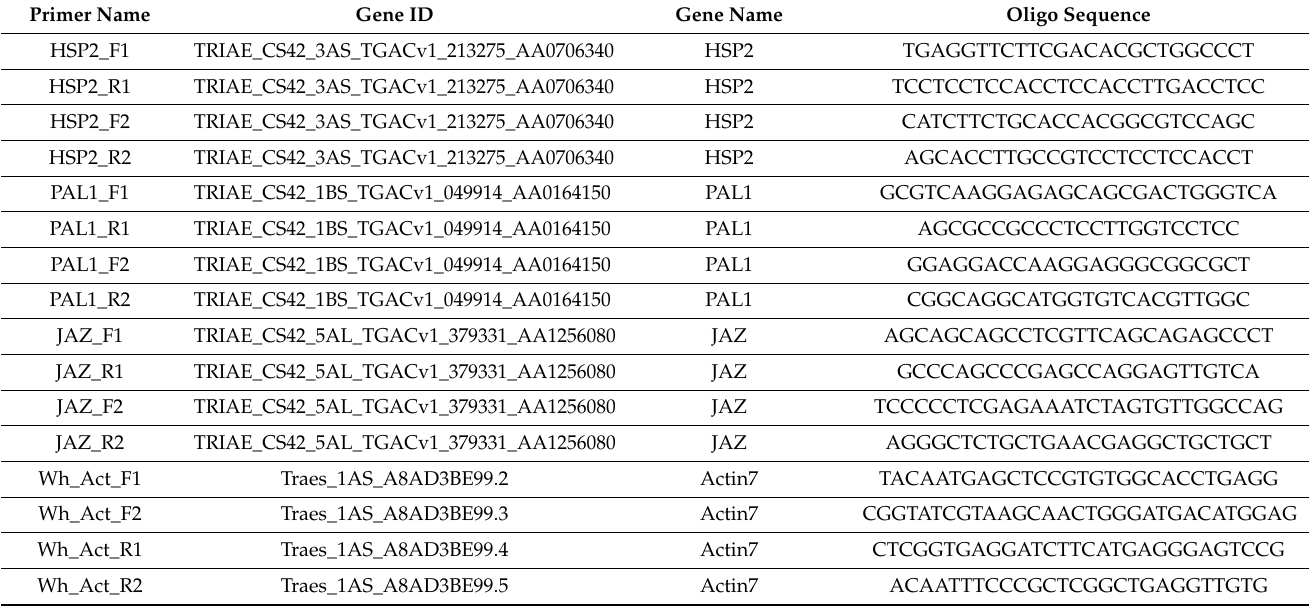
Table 2. Genes and oligonucleotide sequences of primer pairs used for real-time